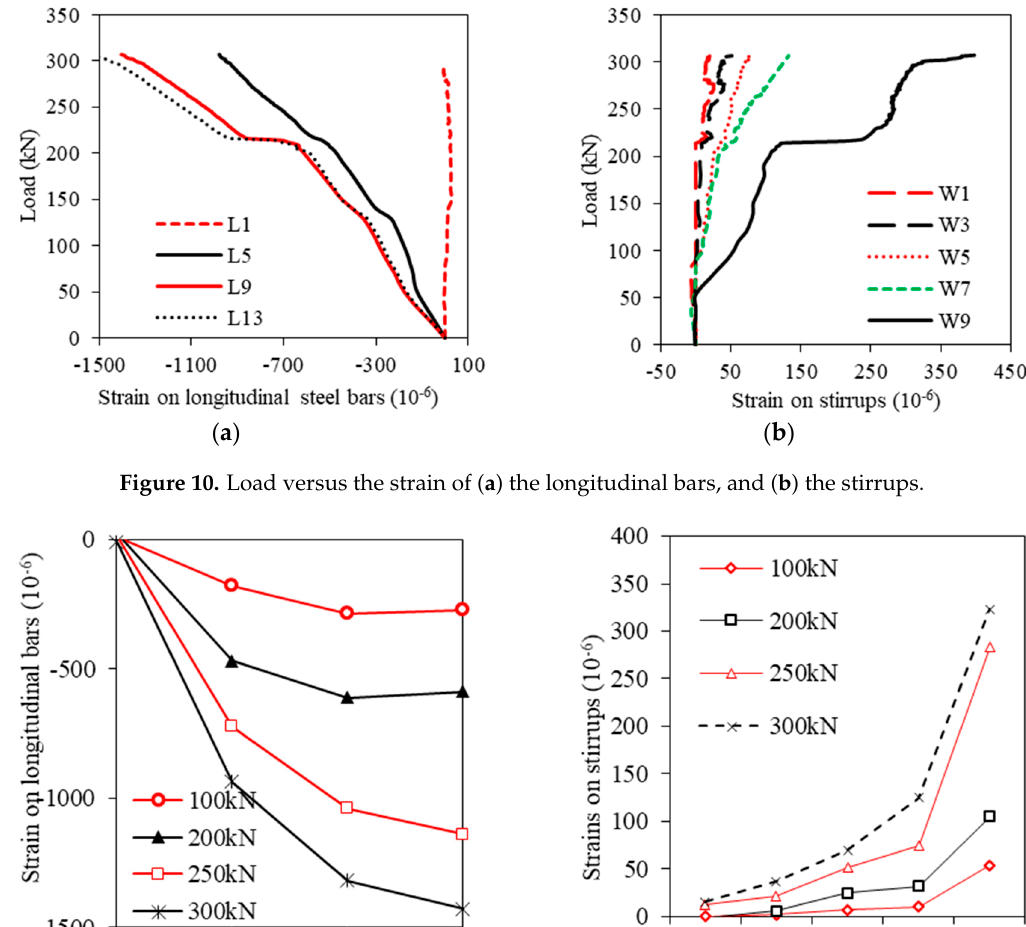
Figure 9. Load versus strain at the steel bolts.